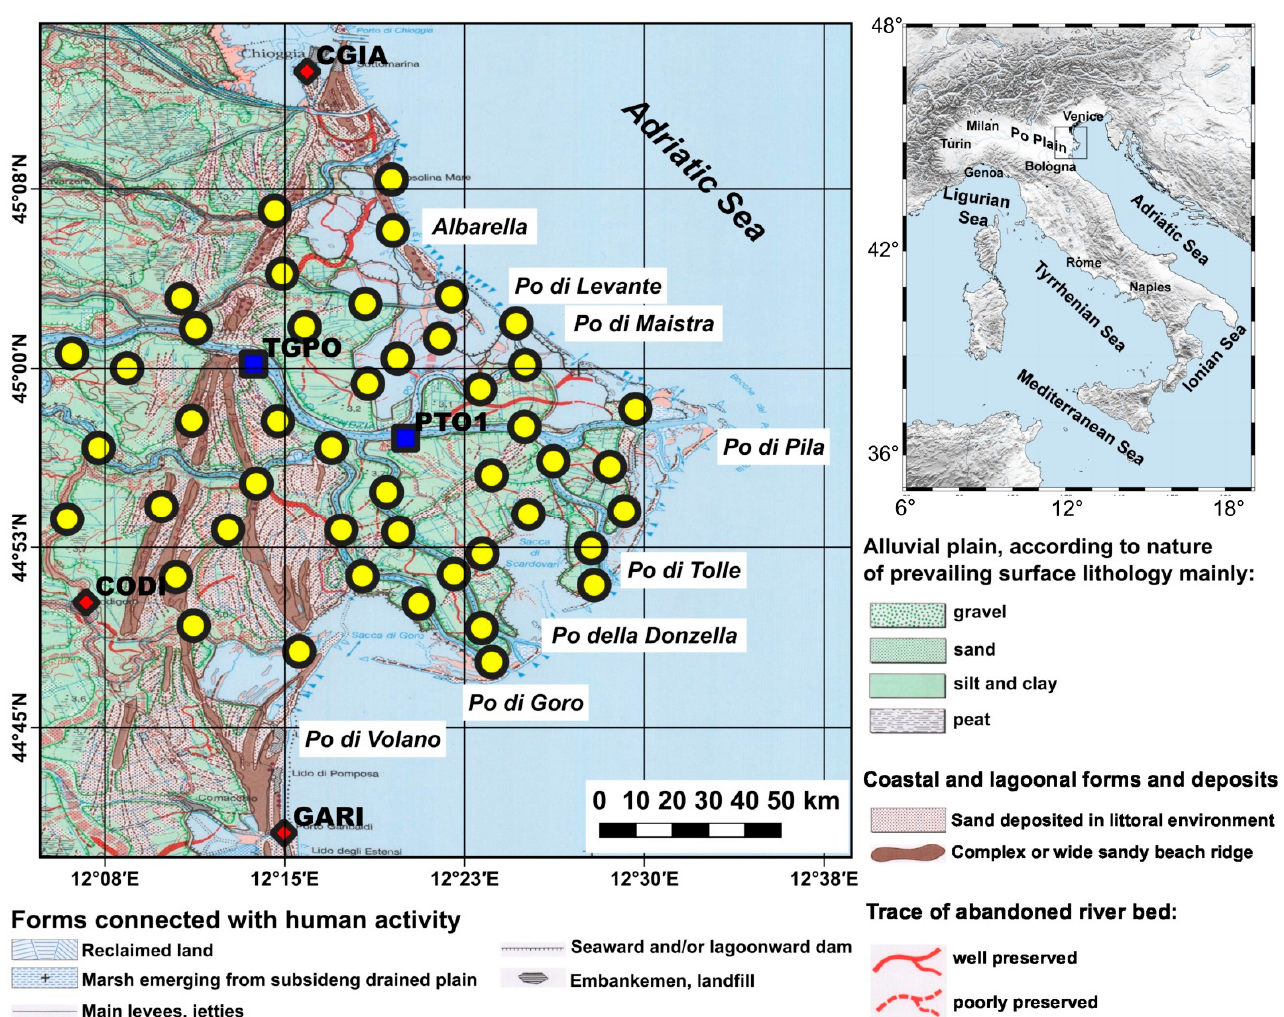
Figure 1. Geomorphological map of the Po River Delta (PRD) area (scheme integrated and modified from “Geomorphological map of Po Plain at 1:250,000 Scale (1999)”). Blue squares and red diamonds indicate the position of the permanent sites respectively located in the PRD and surrounding area. The yellow circles show the location of the Non-Permanent Sites (NPS) belonging to the PODELNET network; in the figure are also shown the positions of the seven Po River terminal branches.